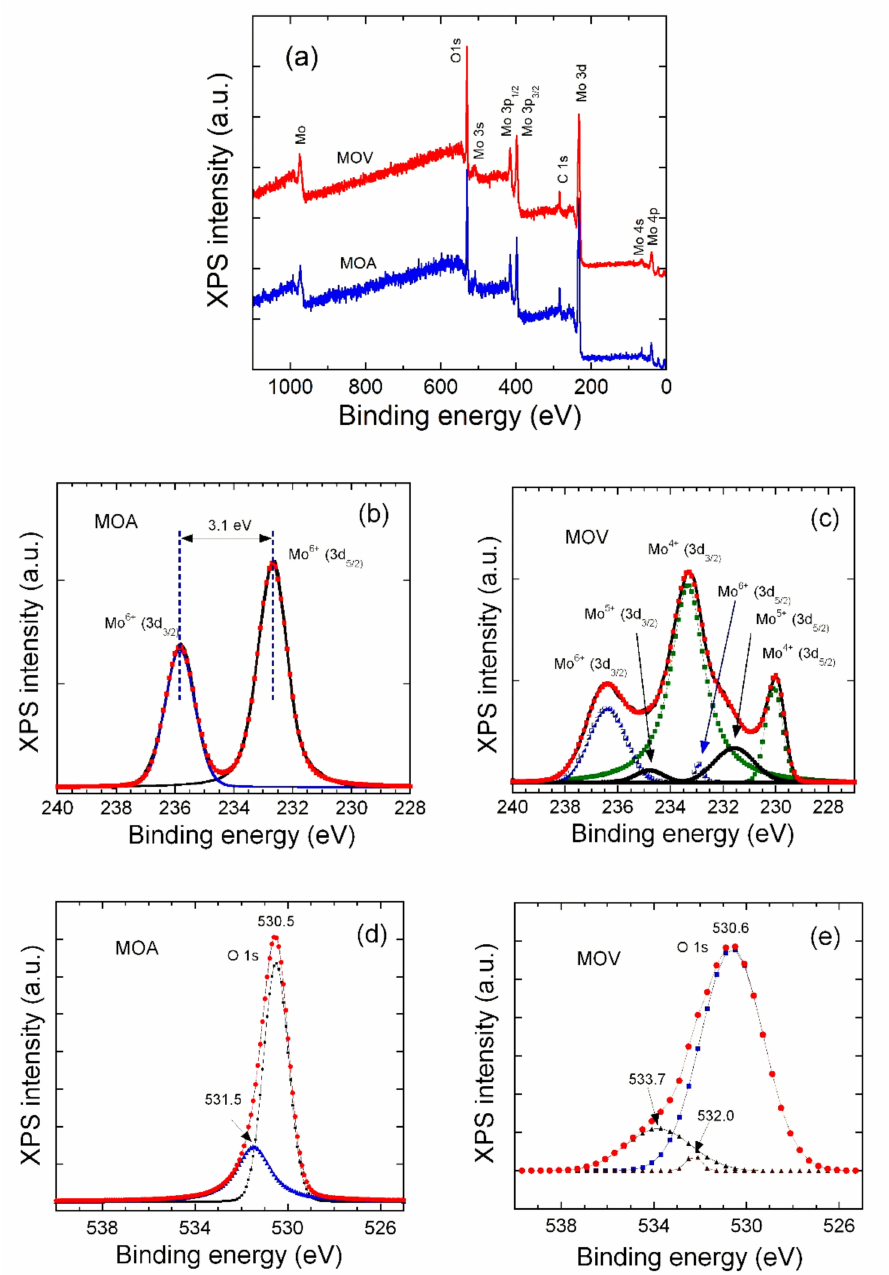
Figure 6. ( a ) XPS survey spectra of the MOA and MOV samples. High-resolution XPS spectra of ( b ) Mo 3d in MOA, ( c ) Mo 3d in MOV, ( d ) O1s in MOA, ( e ) O1s in MOV. The first doublet centered at 230 and 233.3 eV was typically the Mo 3d 5/2 and Mo 3d 3/2 of Mo 4+ , respectively, whereas the second one located at 231.6 and 234.7 eV was due to the Mo 5+ , and, finally, the last one located at 233.1 and 236.3 eV was due to the Mo 6+ [88,89]. The XPS spectra of O1s are presented in Figure 6d,e for the MOA and MOV samples, respectively. The intense peak located at ∼ 530.5 ± 0.1 eV was attributed to the binding energy of Mo–O bonds, whereas the peak at a higher binding energy was assigned to surface states. Therefore, the surface states of the MOV observed in the XPS patterns ascribed the presence of MoO 2 , Mo 4 O 11 , Mo 8 O 23 , and Mo 9 O 26 (Figure 6c). From XPS peak deconvolution, the average Mo valence state of the MOA and MOV sample was determined to be 6.00 and 4.39,